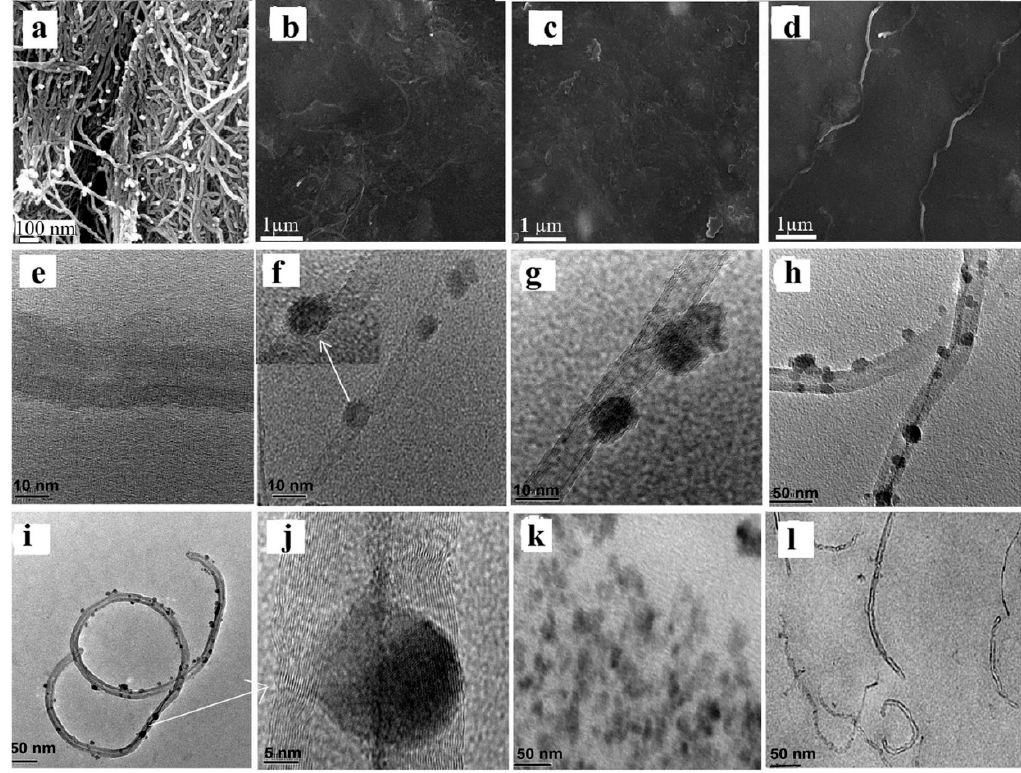
Figure 7. SEM images of Fe 3 O 4 –MWCNT nanohybrids ( a ), NNC ( b ), FNC ( c ), and MNC ( d ); TEM images of MWCNT ( e ), Fe 3 O 4 –MWCNT nanohybrid ( f and g ), NNC ( h – j ); FNC ( k ) and MNC ( l ).